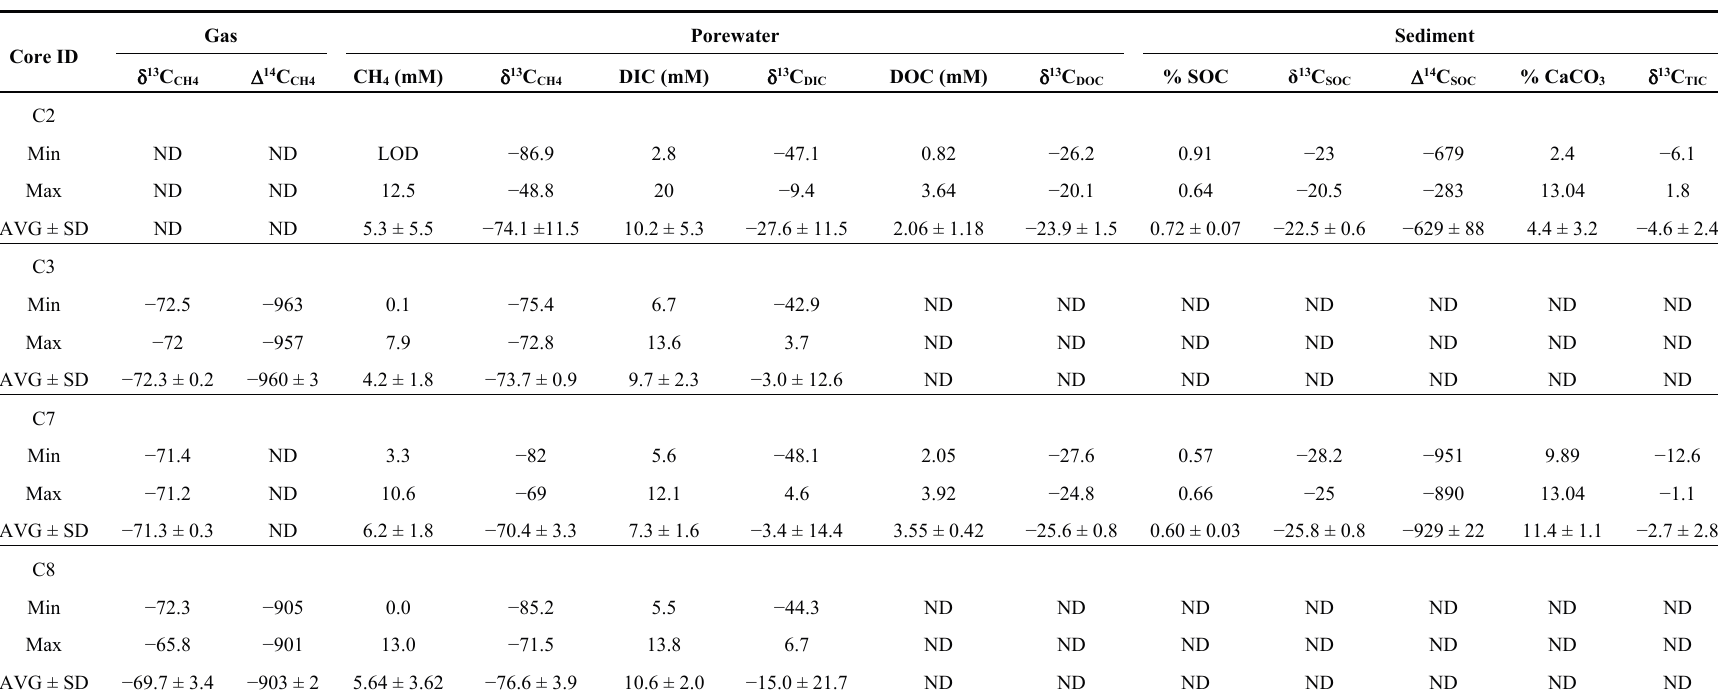
Table 2. Summary of C pool concentrations and δ 13 C, with minimum, maximum and average values for each core. The full data set for each core is available in